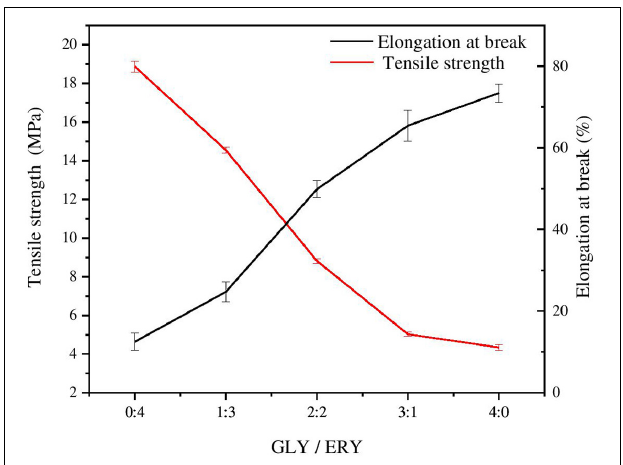
FIGURE 2 | Tensile strength and elongation at break of corn starch-based films supplemented with GLY and ERY (0:4, 1:3, 2:1, 3:1, and